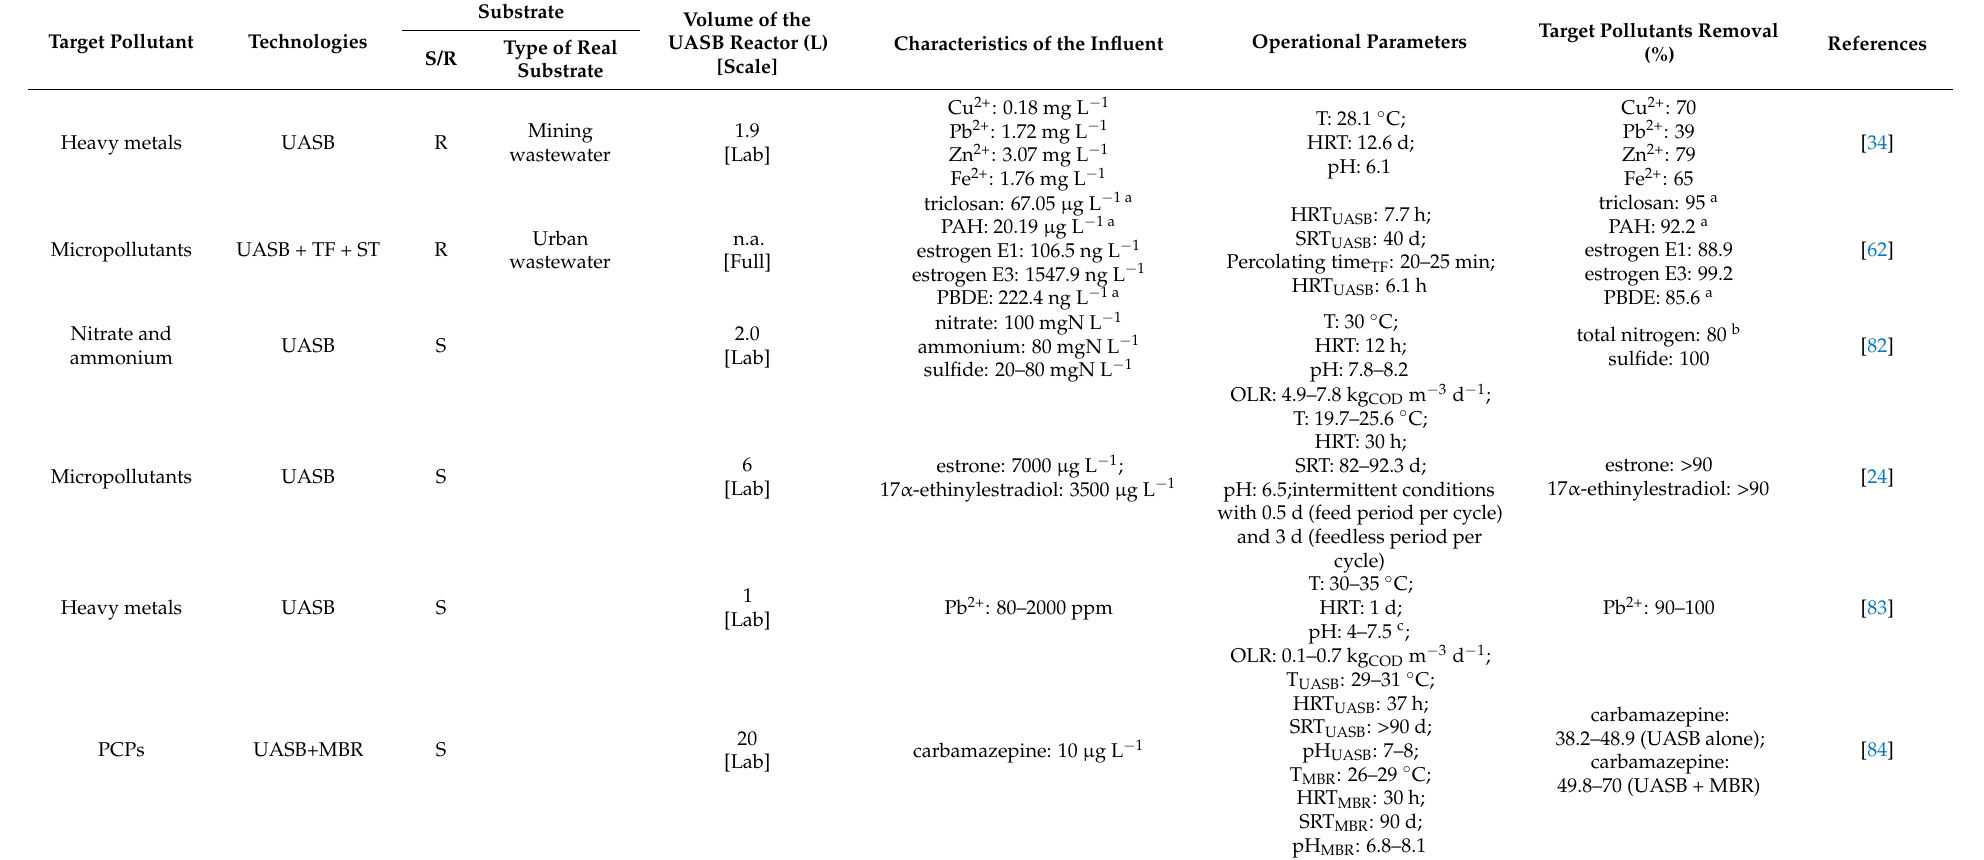
Table 3. PCPs: Pharmaceutical and care products; TCE: trichloroethylene; TP: total phosphorus; TF: Trickling filters; Sedimentation tank; PAH: polycyclic aromatic hydrocarbons; PBDE: polybrominated diphenyl ether; ECA-UASB: Electrochemical assisted UASB. AnMBR: anaerobic membrane bioreactor. MPs: microplastics. a : both in aqueous and particulate form. b : removed partially (12.8%) by sulfide-driven partial denitrification and the remaining (87.2%) by anammox. c : value deduced by figure analysis. d : in case of adding anthraquinone- 2,6-disulfonate (0–100 µ M) and microaeration (0.1 mL min − 1 ). e : in case of adding NO 3 − (in a COD (NO 3 − ) − 1 ratio of 2.5–10). f : in the same reactor. g : info reported in [81]. h : as sum of oxytetracycline, doxycycline, enrofloxacin, chlorotetracycline, lincomycin, sulfamonomethoxine, ofloxacin, norfloxacin, sulfadiazine, bacitracin, tetracycline, erythromycin-H 2 O, ciprofloxacin, trimethoprim, sulfachlorpyridazine,